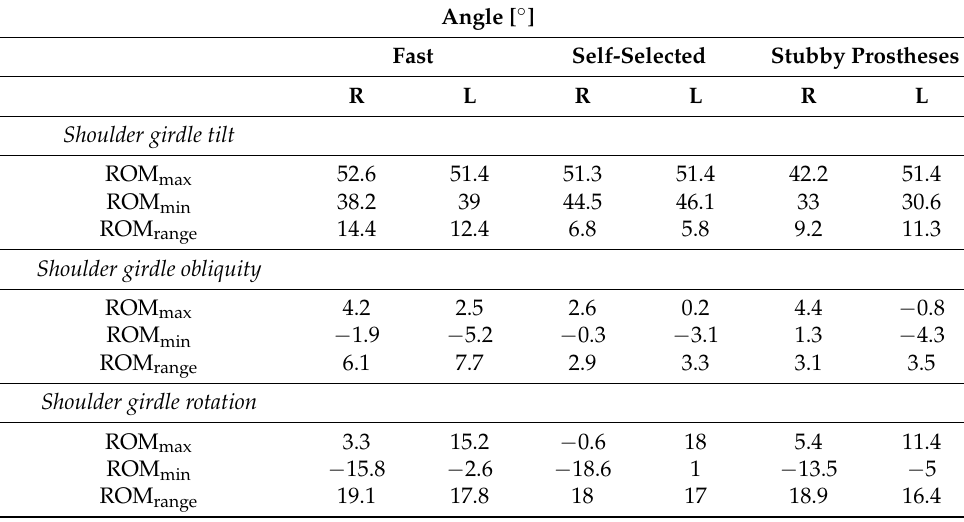
Table 2. Parameters characterizing the range of motion for prosthetic gait (fast gait, self-selected gait speed and gait with stubby